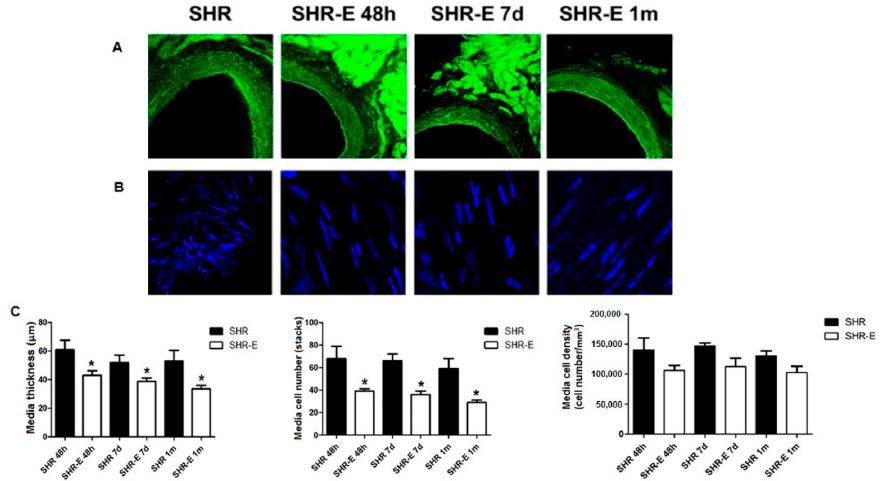
Figure 3. Medial layer of the left anterior descending coronary artery. Shown are rings (confocal microscopy images, × 20, zoom 2) ( A ), cell nuclei (confocal microscopy images, × 20, zoom 8) ( B ) and the composition of the medial layer ( C ) of the coronary artery in treatment groups (48 h) and withdrawal groups (7 days and 1 month). SHRs, rats treated with vehicle; SHR-Es, rats treated with esmolol; n = 9 rats for each experimental group. Values are mean ± SEM. * p < 0.05 vs. SHRs.